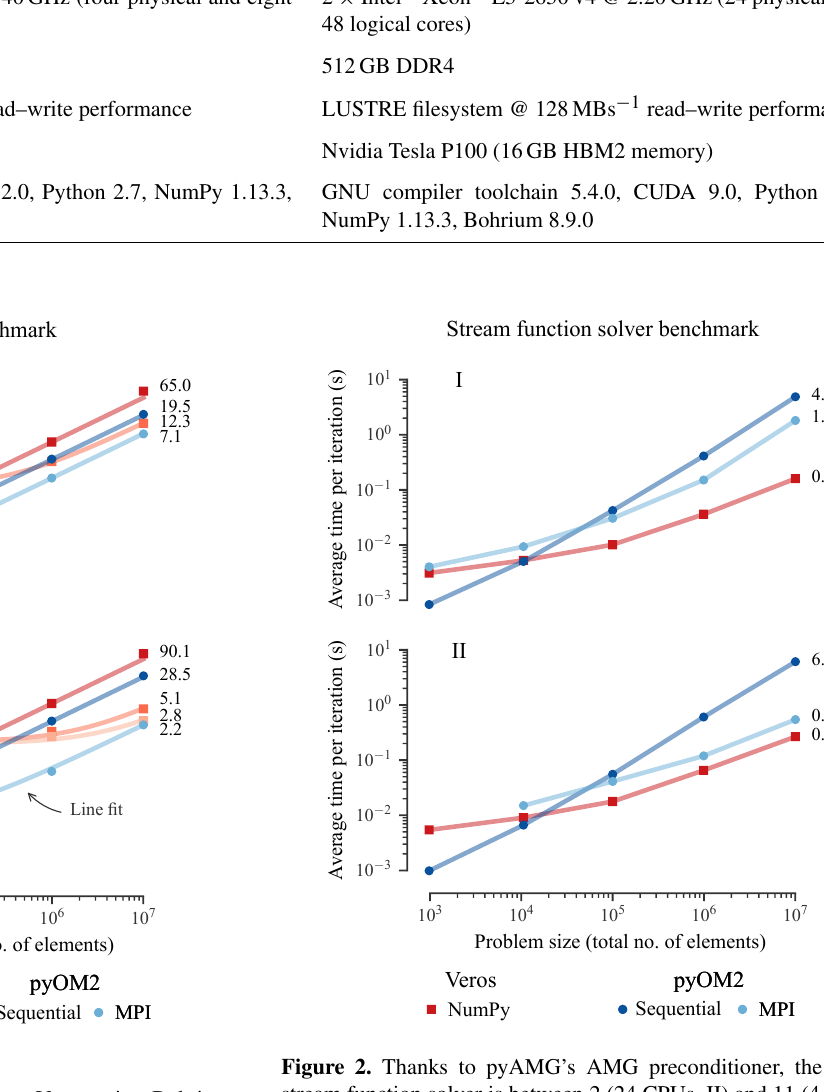
Figure 1. In terms of overall performance, Veros using Bohrium (Bh) is slower than pyOM by a factor of about 1.3 to 2.3 for large problems, depending on the hardware architecture (I and II; see Ta- ble 1). Solid lines are line fits, suggesting a linear scaling with con- stant overheads for all components.